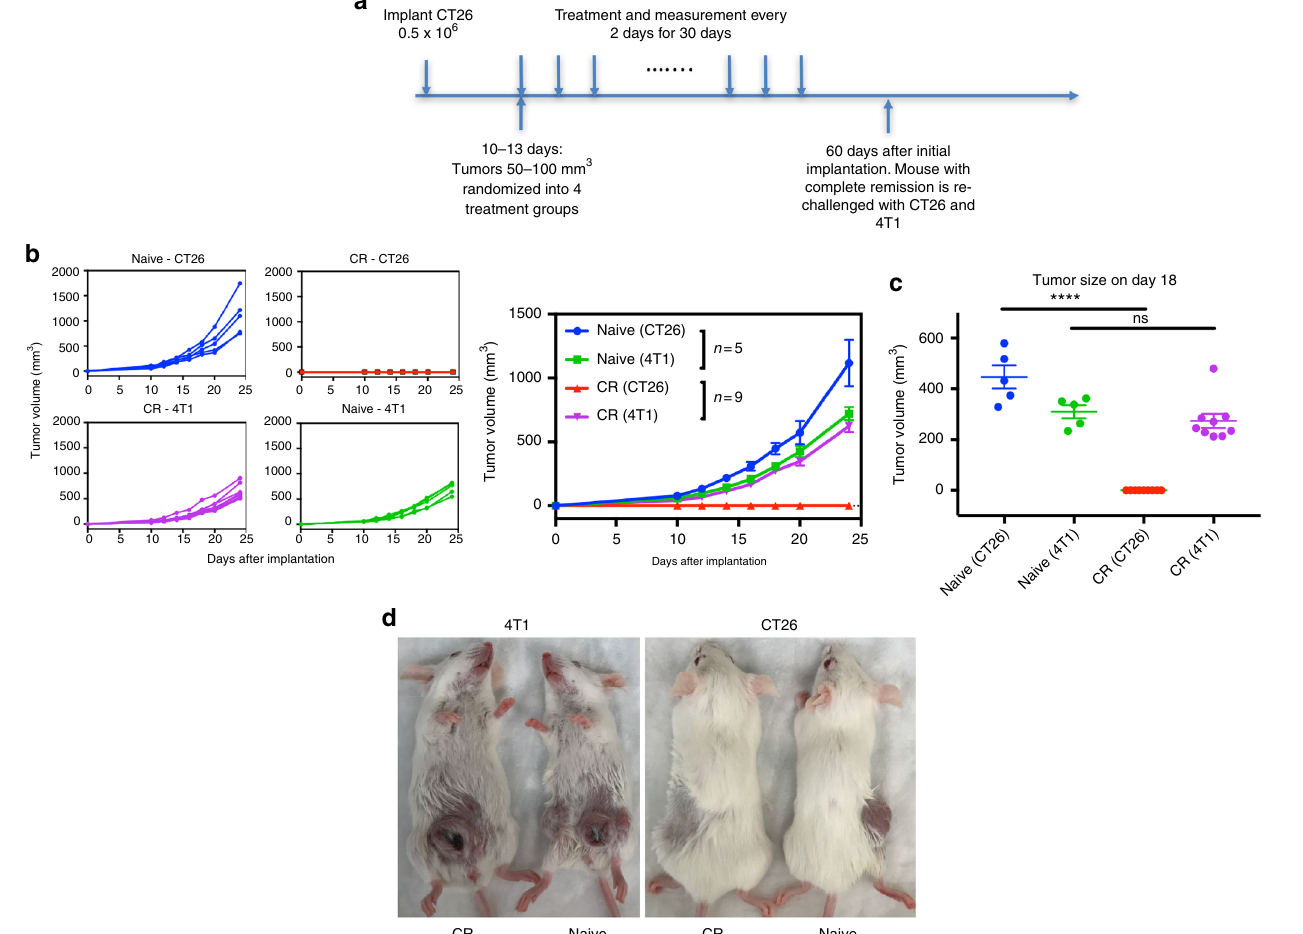
Fig. 2 PP2A inhibition and PD-1 blockade result in a long-term antitumor antigenic-speci fi c memory of cured animals. a BALB/c mice were inoculated with 0.5 × 10 6 CT26 cells subcutaneously and treated as above. CR or naive control mice were re-challenged about 60-days after initial implantation with 0.5 × 10 6 CT26 cells in the thoracic fl ank in combination with 1.25 × 10 5 4T1 breast carcinoma cells in the mammillary fat pad. b , c Naive — CT26 (blue), CR — CT26 (red), naive — 4T1 (green), CR — 4T1 (purple). b Individual and mean tumor growth curves over time. c Quantitation of CT26 and 4T1 tumor